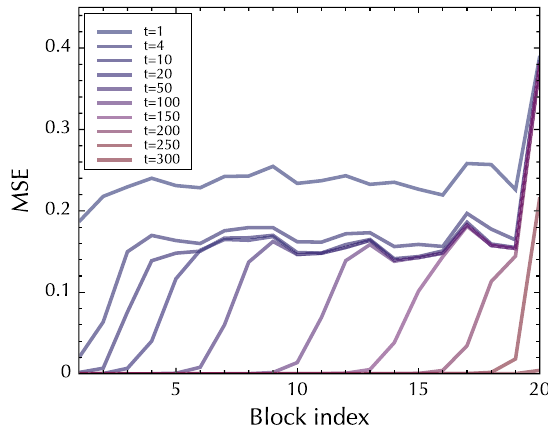
FIG. 4. Construction of the measurement matrix F for seeded compressed sensing. The elements of the signal vector are split into L (here, L ¼ 8 ) equal-sized blocks; the number of mea-